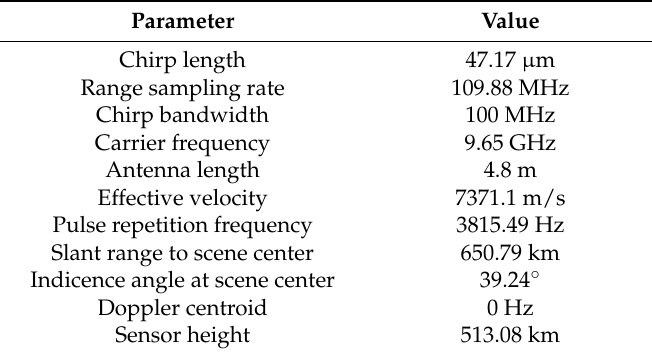
Table 1. Summary of sensor model parameters used for